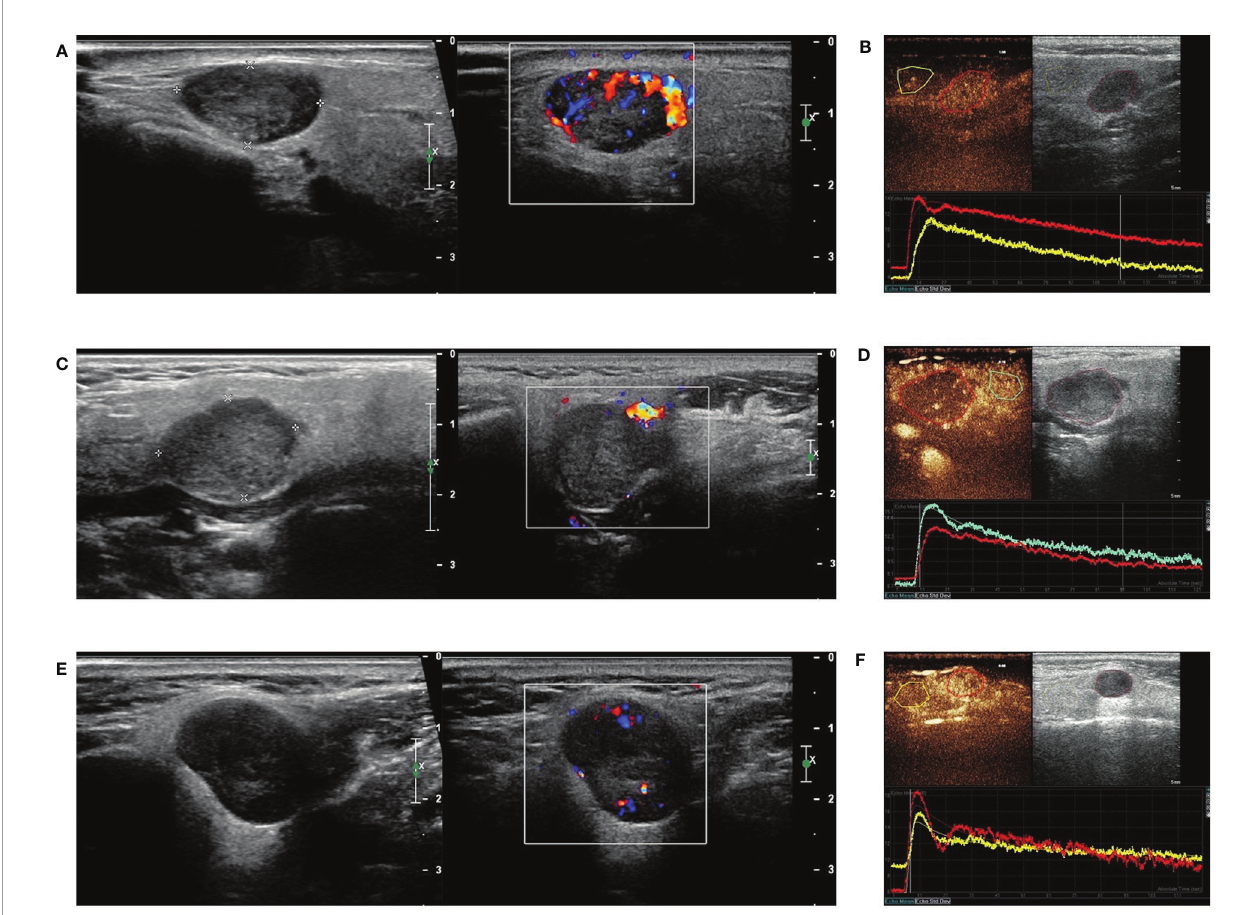
FIGURE 5 | B-mode sonography, Color Doppler sonography (CDs), and dual-imaging of CEUS and gray-scale US with ROI in the remarkable perfusion areas in both the lesions and the surrounding tissues. (A) Hypoechoic and regular masses with well-de fi ned border in the parotid glands of patients with WT, and CDs displayed marked intratumal vascularity in the lesion (grade III); (B) TIC analysis by the QLAB software showed that the red line represented the lesion of WT, while the yellow line represented the surrounding tissues; (C) Hypoechoic and regular masses with a well-de fi ned border in the parotid glands of patients with PA and CDs showing no blood fl ow signal in the lesion (grade 0); (D) TIC analysis by the QLAB software showing that the red line represented the lesion of PA, while the green line represented the surrounding tissues; (E) hypoechoic and regular masses with a well-de fi ned border in the parotid glands of patients with BCA and CDs showing a small amount of blood fl ow in the lesion (grade II); (F) TIC analysis by the QLAB software showing that the red line represented the lesion of BCA, while the yellow line represents the surrounding tissues. ROI, region of interest; TIC, time-intensity